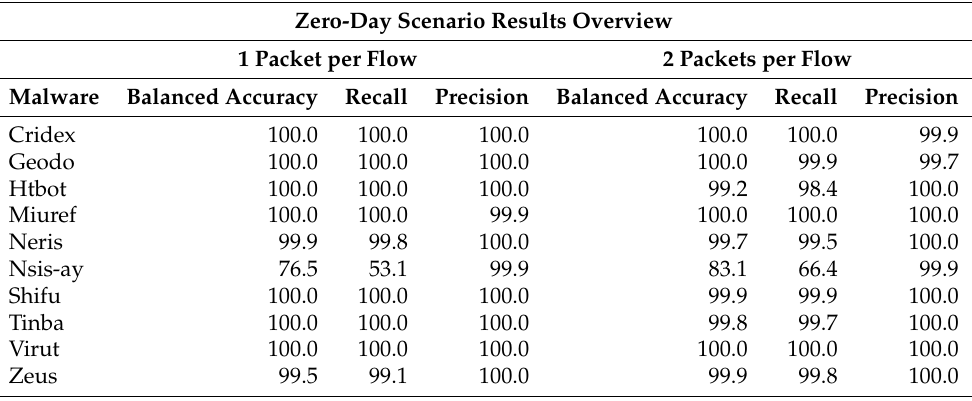
Figure 2. Balanced accuracy of simulated zero-day scenario, training for ten epochs on nine malicious categories from USTC-TFC2016 dataset and testing on the tenth while taking 6000 flows from each benign category in a 90%/10% split for training and testing. All scenarios except testing on Nsis-ay are near 100% balanced accuracy after ten epochs of training. Table 3. An overview of the results of the simulated zero-day scenario using the USTC16